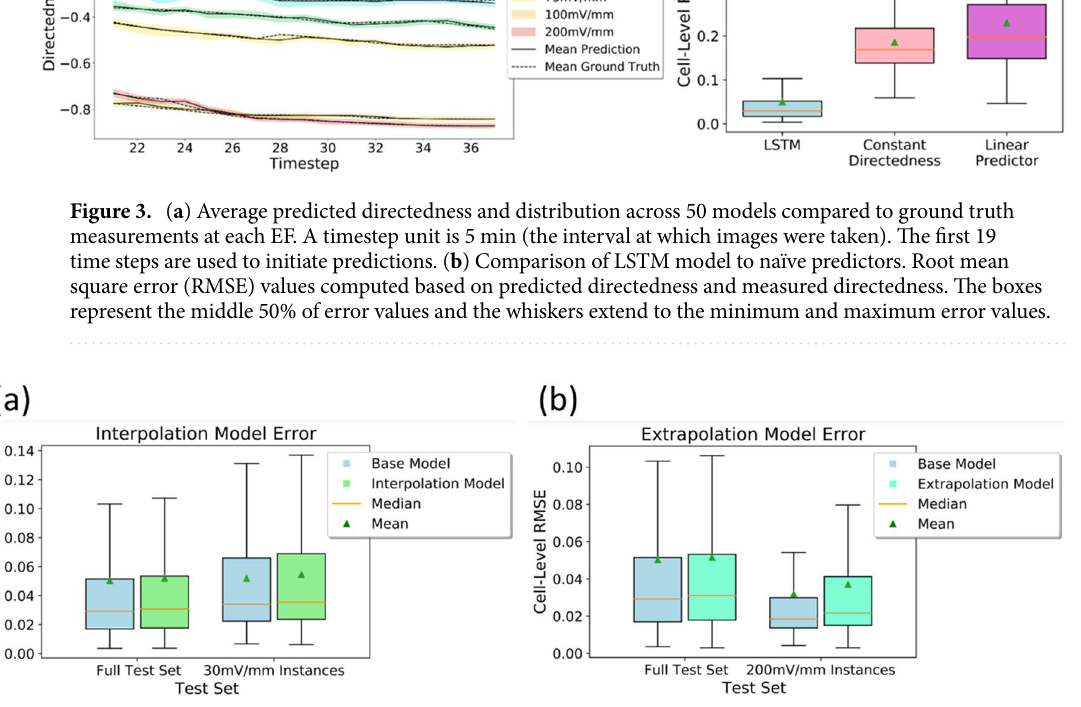
Figure 4. ( a ) Distributions of cell-level test set RMSE values of the base model and a model with identical architecture which was trained with a modified training set from which the 30 mV/mm instances were removed. Error distributions shown for both the complete testing set and for the 30 mV/mm test instances. ( b ) Distributions of cell-level test set RMSE values of the base model and a model with identical architecture which was trained with a modified training set from which the 200 mV/mm instances were removed. Error distributions shown for both the complete testing set and for the 200 mV/mm test instances. The boxes represent the middle 50% of error values and the whiskers extend to the minimum and maximum error